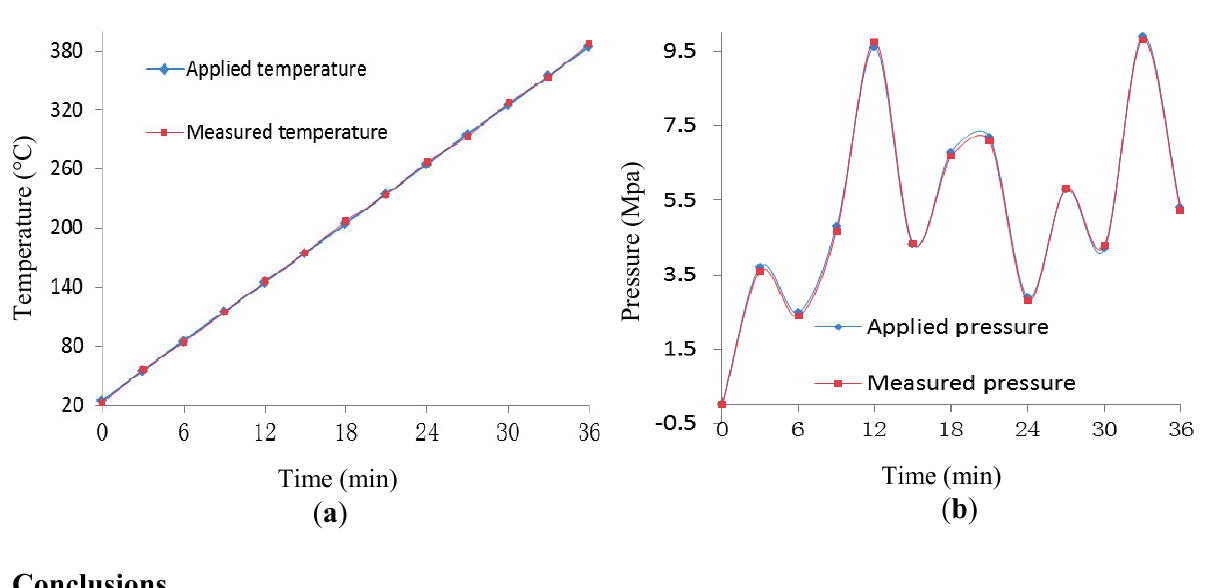
Figure 8. Experimental results of simultaneous measurement of temperature and pressure. ( a ) measurement of temperature; ( b ) measurement of